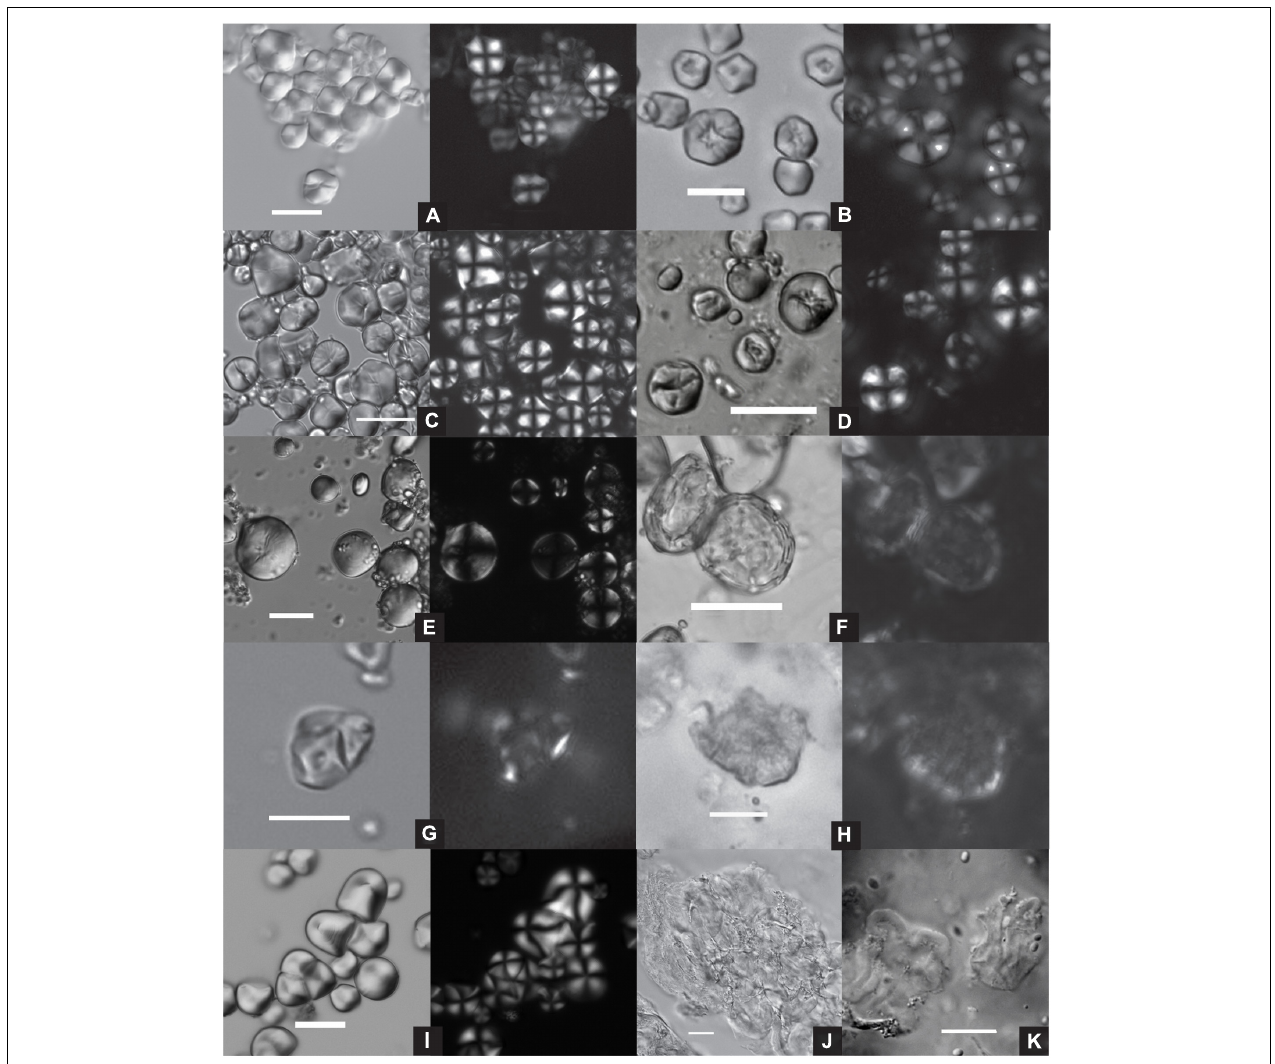
FIGURE 3 | Modern starch reference examples related to this paper (each starch image is shown in DIC and polarized views). (A) Broomcorn millet Panicum miliaceum ; (B) mashed broomcorn millet with deep fissures and concave center in bright field; (C) job’s tears Coix lacryma-jobi ; (D) mashed Job’s tears with deep fissures and concave center in bright field; (E) barley Hordeum vulgare ; (F) barley fermented for 40 days with concave center, deep fissures, and pits in bright field, and disappeared birefringence in polarized light; (G) rice Oryza sativa , fermented for 18 days, concave center in bright field and blurry birefringence in polarized light; (H) rice, fermented for 1 year, blurry granule edge in bright field, birefringence only shown at the edge in polarized light; (I) snake gourd root Trichosanthes kirilowii ; (J) gelatinized barley, boiled for 3 min; (K) gelatinized starch granules from the modern-day millet beer, hunjiu , produced in Yulin, Shaanxi. (Scales, A,B,G,H : 10 µ m; rest: 20 µ